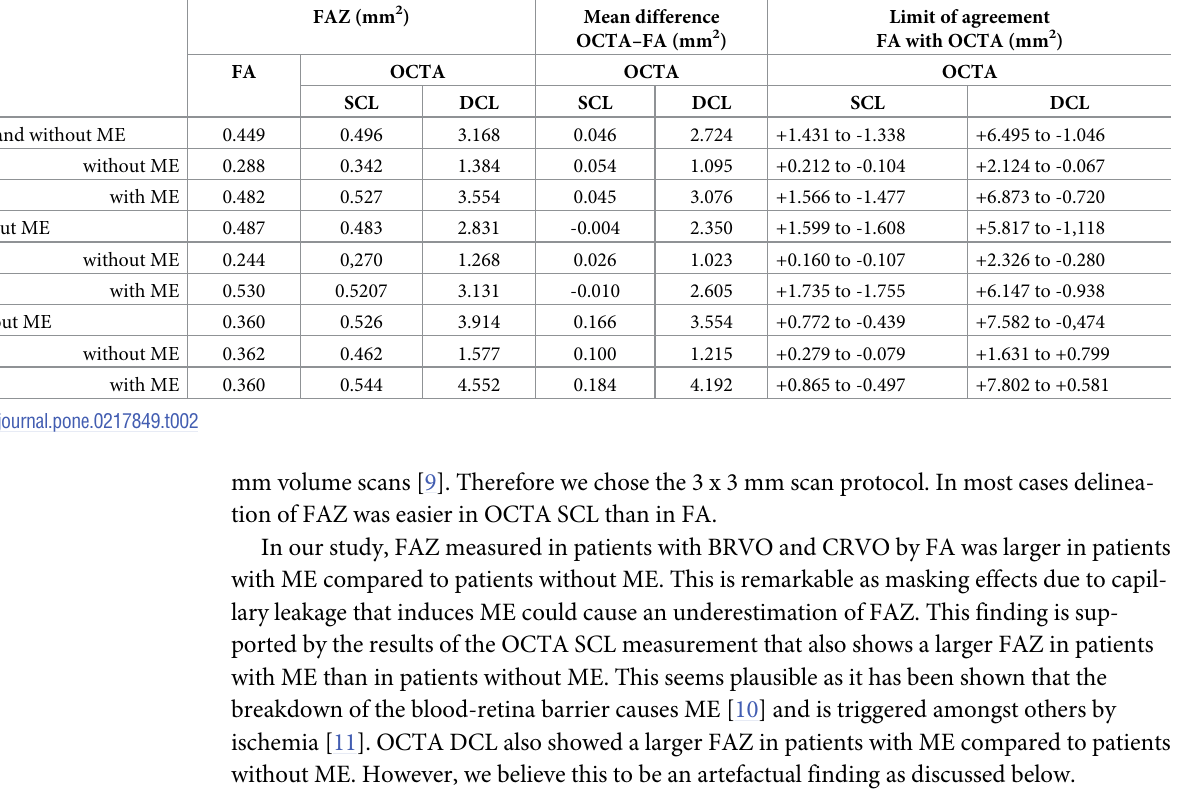
Table 2. FAZ in FA and OCTA (SCL and DCL) for all patients and the subgroups CRVO/BRVO, with and without ME, is shown in the left column (mean values). The middle column reflects the mean difference between FA and OCTA (SCL and DCL). Limit of agreement between FA and OCTA (SCL and DCL) is shown in the right column.